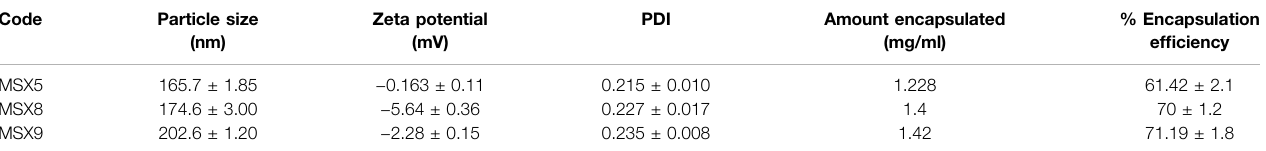
TABLE 6 | Characteristics of optimized formulations of methotrexate.